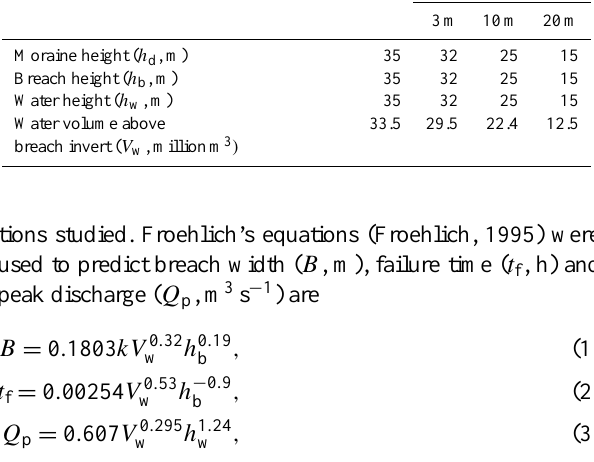
Scenario Lake lowering Current conditions 3m 10m 20m